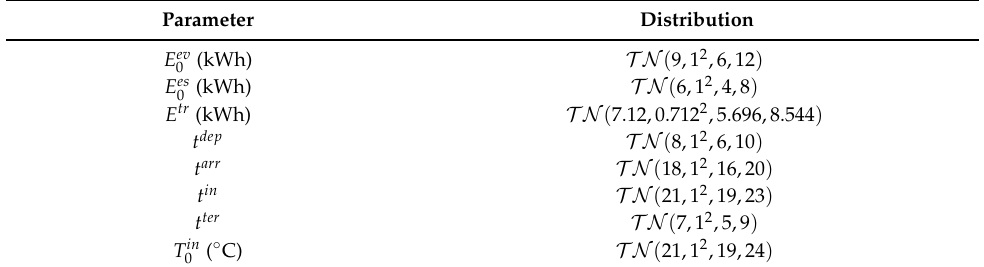
Table 2. Operating parameters for the electric vehicle (EV), energy storage (ES), wet appliances (WAs), and heating, ventilation, and air conditioning (HVAC). EV ES WA HVAC Pa rameter Value Parameter Value Parameter Value Parameter Value T dur (h) 2 0.56 0.63 2.2 0.95 0.93 0.63